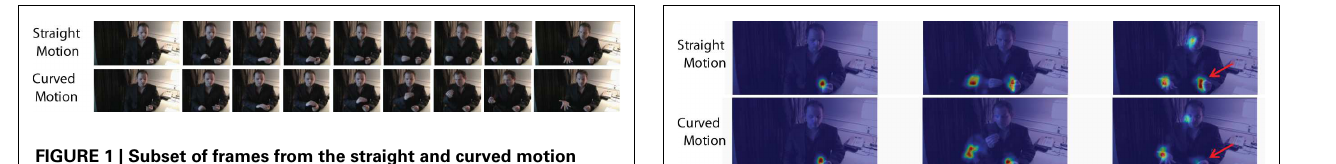
FIGURE 1 | Subset of frames from the straight and curved motion videos (see also Movies S1 and S2 in Supplementary Material). area ( > 20 units per sample) plus the 200 ms before and after. Such periods are probably due to partial blinks, where the pupil is never fully occluded (thus failing to be identified as a blink by EyeLink; Troncoso et al., 2008).